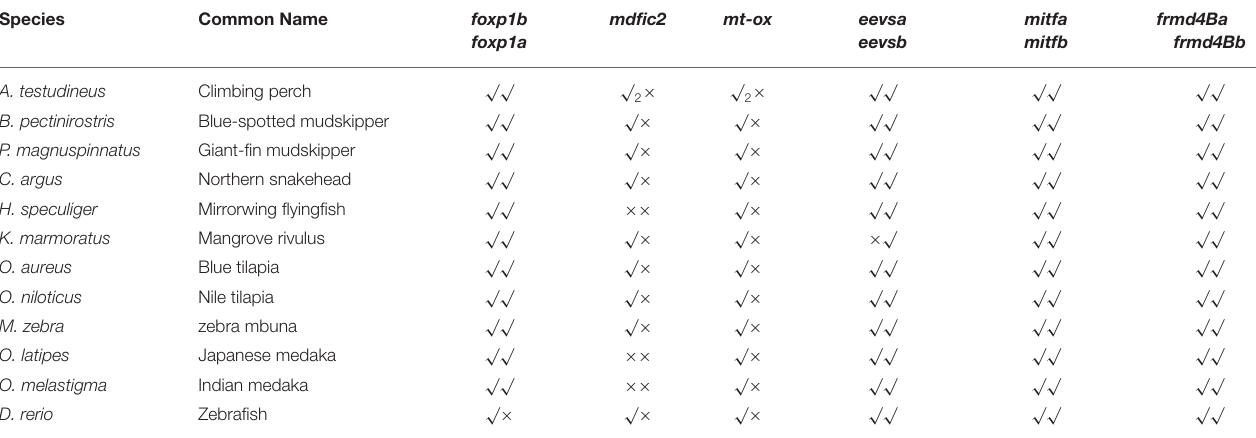
TABLE 5 | Genetic analysis of eevs and mt-ox genes in selected fishes. Species